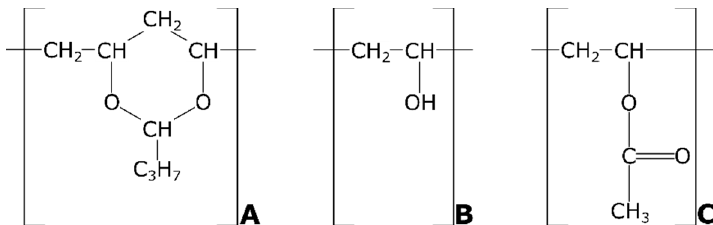
Figure 3. Butyral ( A ), Alcohol ( B ) and Acetate ( C ) groups of commercial PVB compositions. The relative amount of A:B:C varies with the targeted application and properties [27].